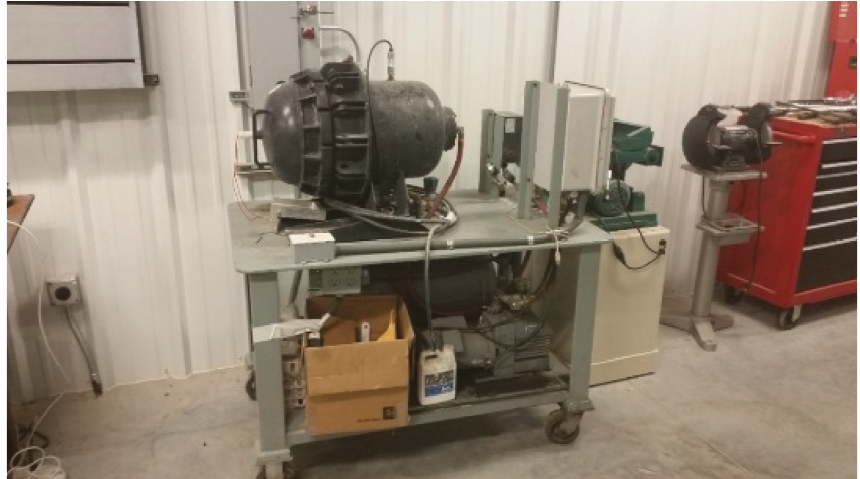
Figure 1: 38L explosive chamber [9].